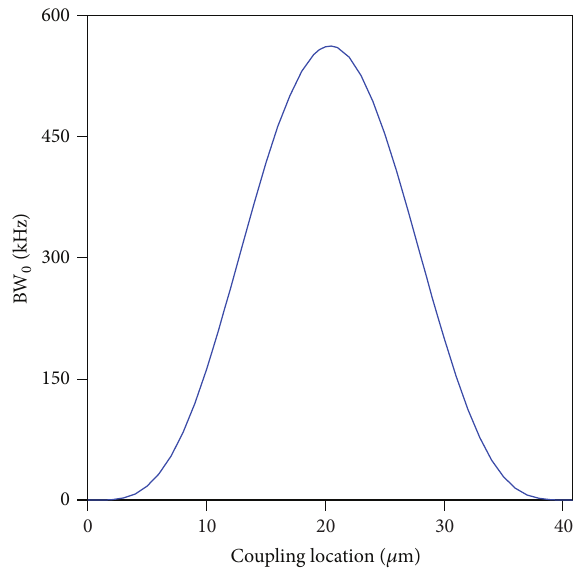
Figure 14: Variation of the bandwidth of the unactuated filter with the attachment